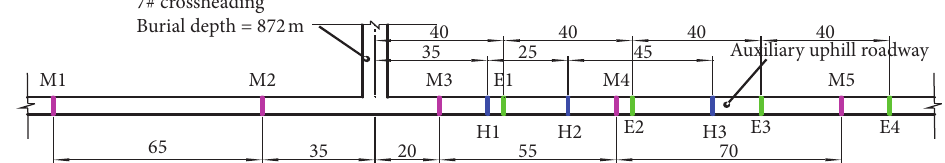
Figure 5: Arrangement of test stations (unit: m).